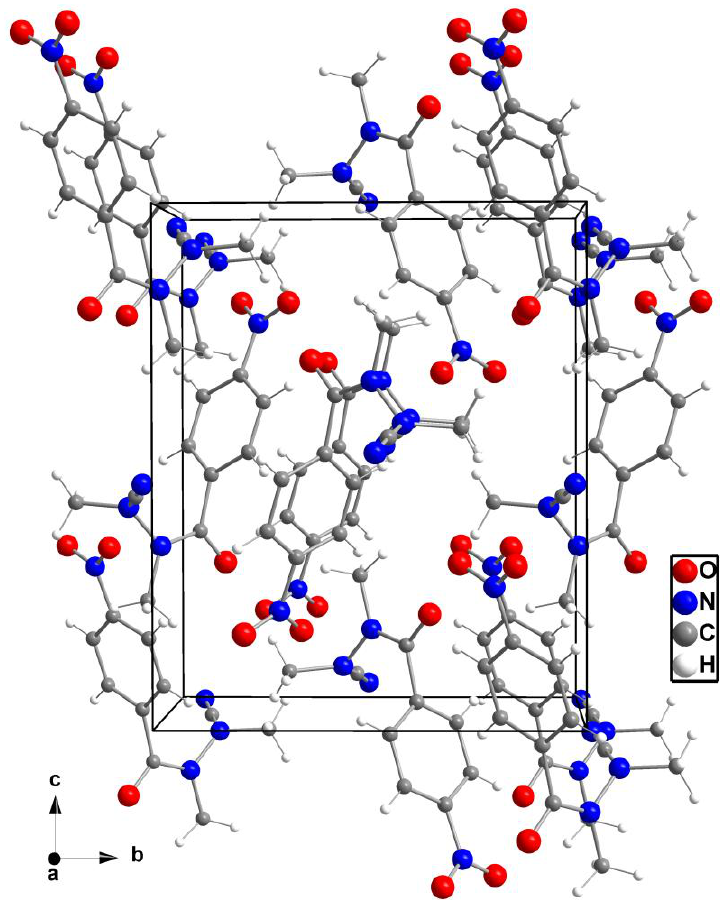
Figure 2. Packing of the molecules in the unit cell in a view along a .